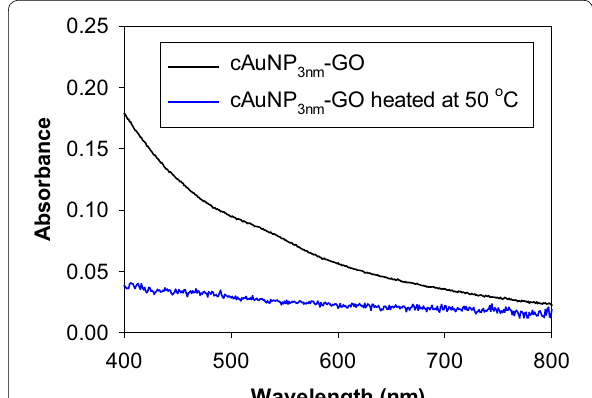
(Fig. 8, 100 °C), particles are more aggregated with a few particles slightly merging together. After the heat